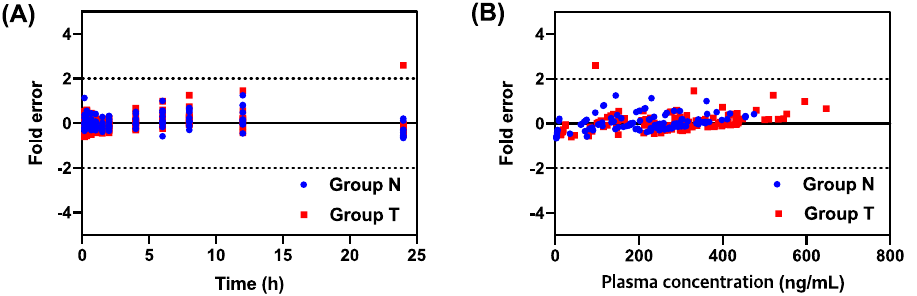
Figure 3. Residual plots written with the pharmacokinetic modeling values of non-pretreated rats (Group N) and ticagrelor-pretreated rats (Group T). ( A ) Fold error vs. time; ( B ) fold error vs. plasma concentration.